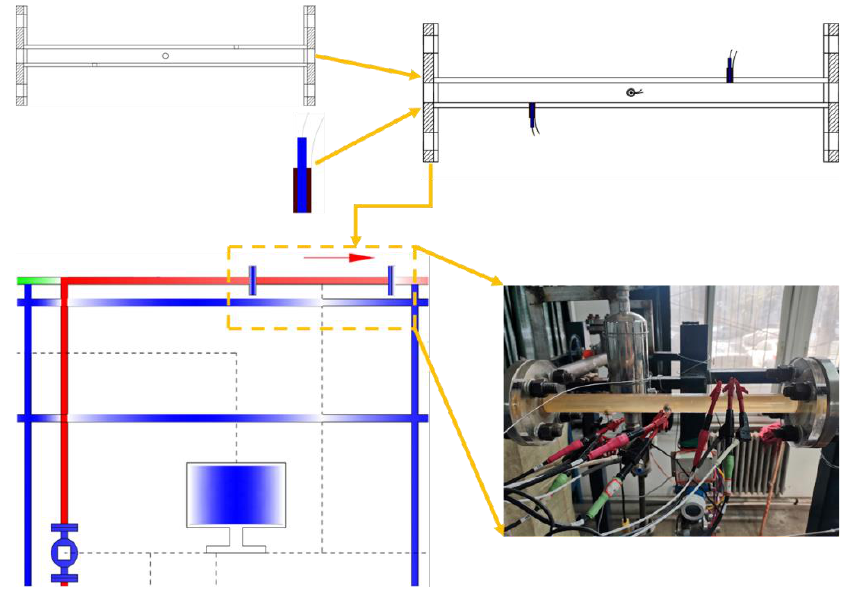
Figure 2. Experimental section of tube flow electrochemical corrosion.